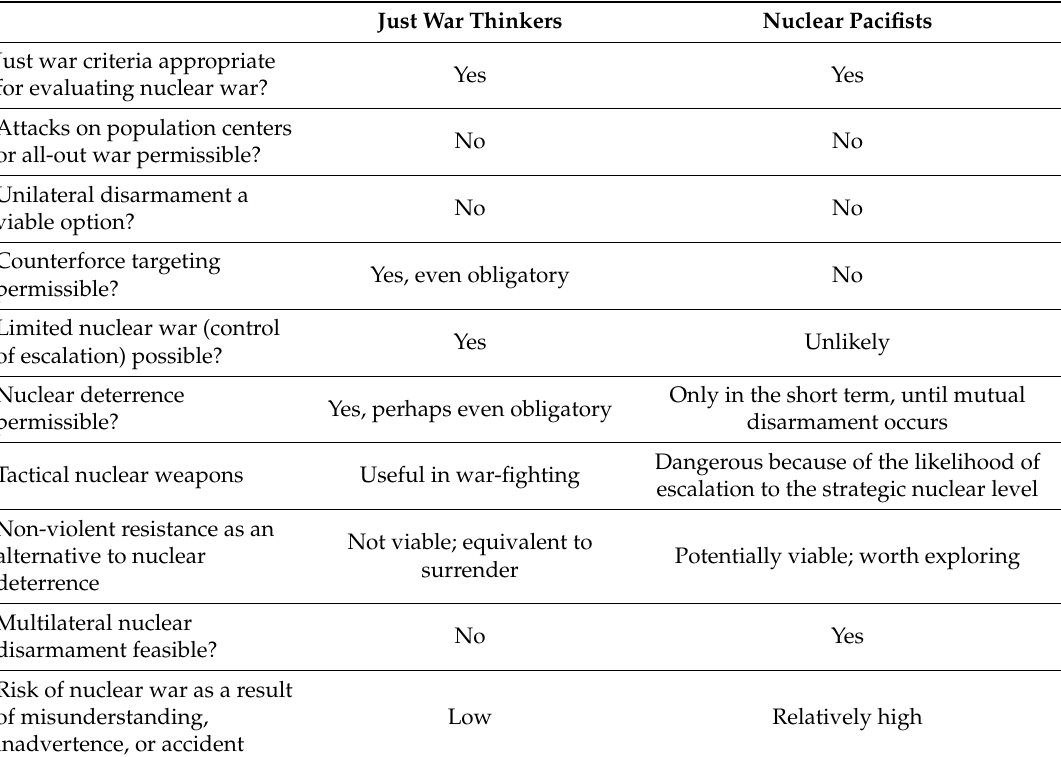
Table 1. Just War Thinkers and Nuclear Pacifists: A